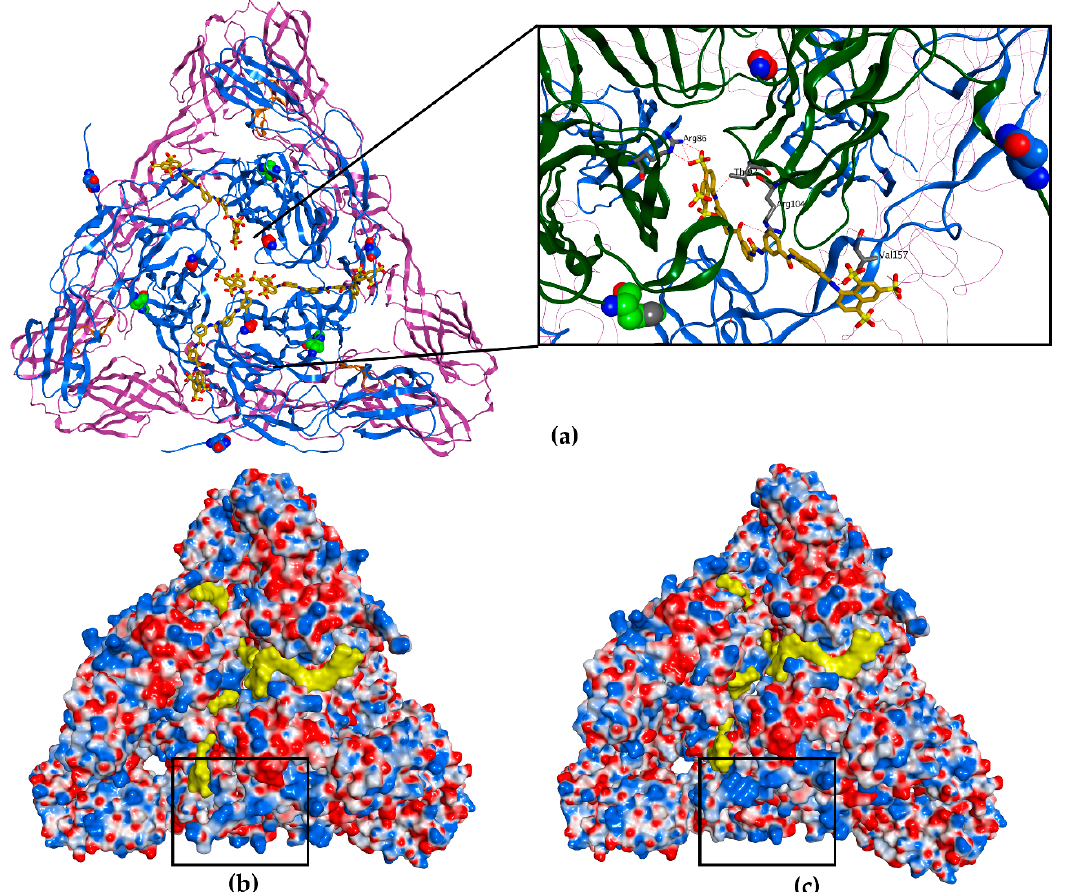
Figure 4. Molecular docking of suramin to a mature CHIKV spike ( a ) The top view of a full wt E1-E2 heterotrimer (PDB ID 3J2W). The E2 proteins are represented as blue ribbon, the E1 as purple ribbon and the fusion loop as orange ribbon; the N5 and H18 residues are represented with carbon atoms in blue and green, respectively, and residue G82 with carbon atoms in red, belong to E2. Suramin is represented in yellow (3 molecules, carbon atoms and molecular surface). The inset (black rectangle) shows a clearer magnified view of the spike core and the positioning of suramin with respect to the residues N5, H18 and G82. ( b ) Electrostatic potential (Coulombic surface coloring) of the heterotrimer of wt CHIKV. The black rectangle marks the N-terminal domain of one E2 protein, where the positive charges are found. ( c ) Electrostatic potential (Coulombic surface coloring) of the heterotrimer of the N5R / H18Q mutant, CHIKV S9. The black rectangle highlights the N-terminal domain of E2 showing an increase in positive charges (blue molecular surface). For presentation purposes, the transmembrane and C-terminal segments of the E1 and E2, which interact with capsid proteins seen in ( a ), were